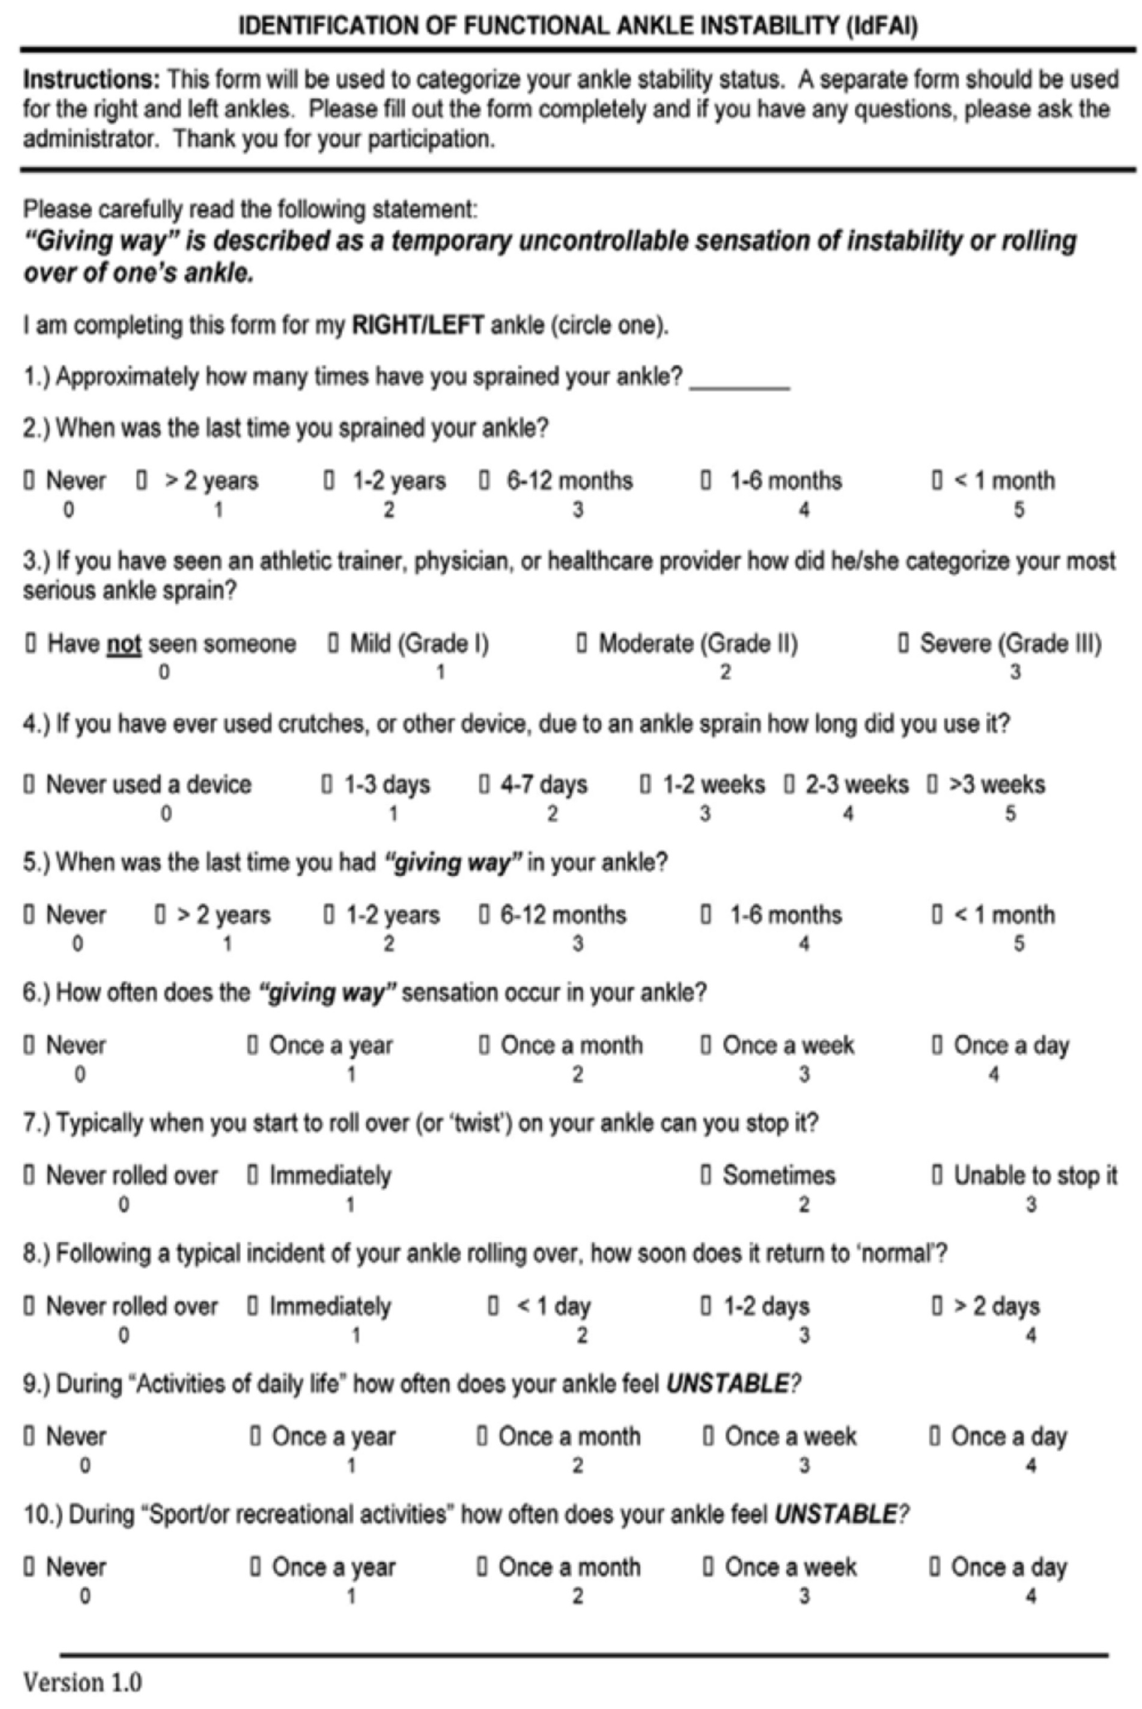
The Identification of Functional Ankle Fig. 1: